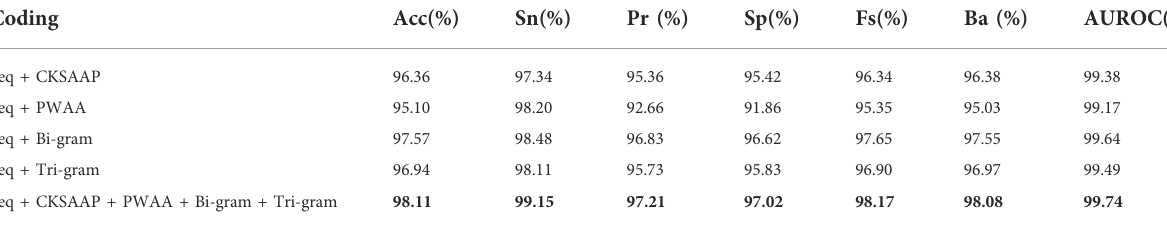
TABLE 2 Comparison of different combination feature coding methods. Coding